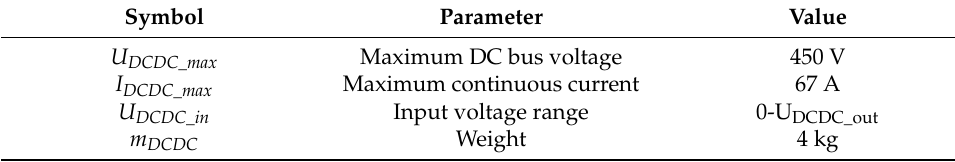
Table 5. Parameters of the DC/DC fuel cell converter.